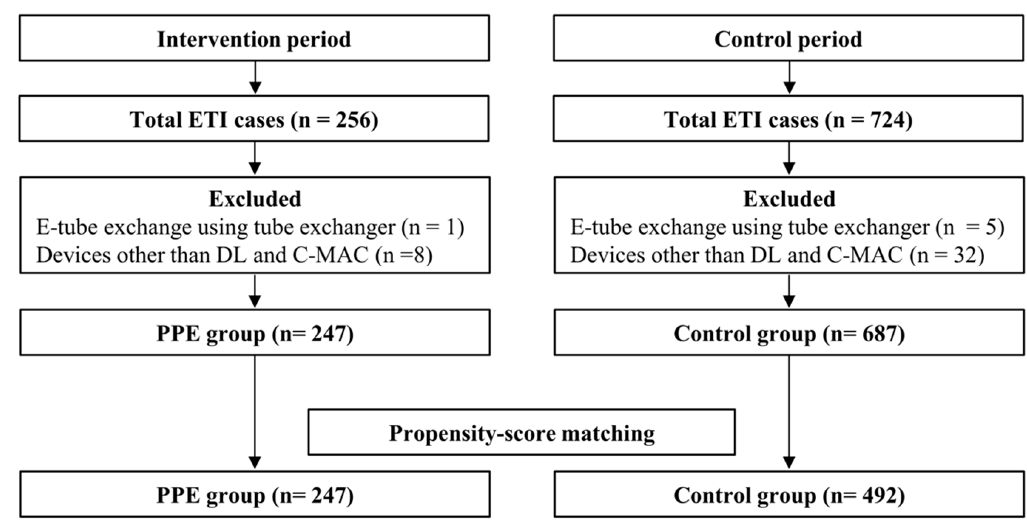
Figure 1. Study flowchart. ETI, endotracheal intubation; E-tube, endotracheal tube; DL, direct laryngoscope; C-MAC, C-MAC video laryngoscope; PPE, personal protective equipment. Table 1. Baseline characteristics of the patients and ETI procedures.